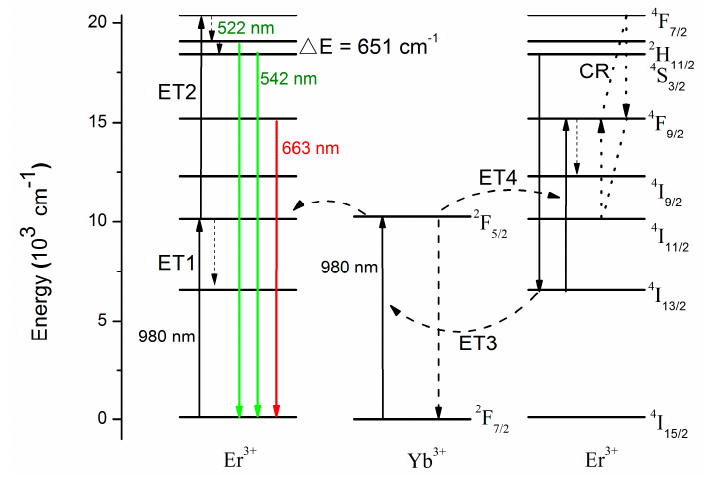
Figure 1. Schematic diagram of energy levels and transitions of Yb 3+ and Er 3+ ions by 980 nm